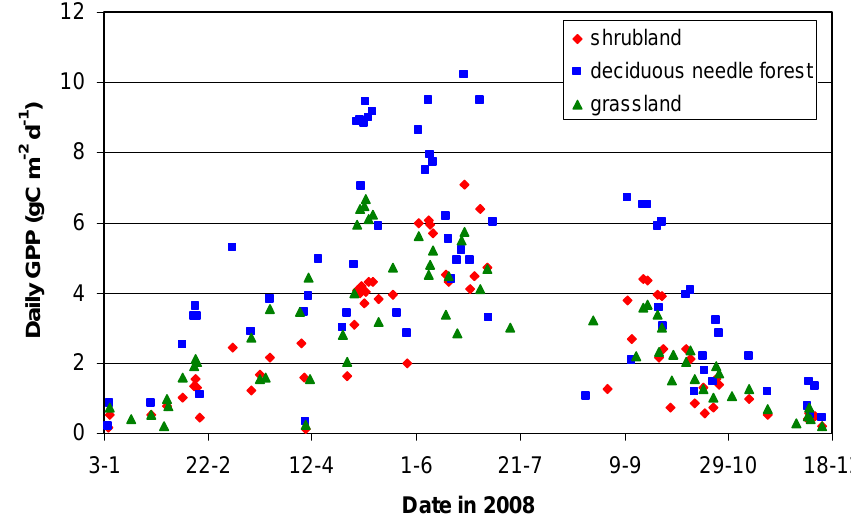
Figure 5. Time-series comparison for daily values of GPP (gC·m -2 ·day -1 ) in 2008 for selected locations in three different